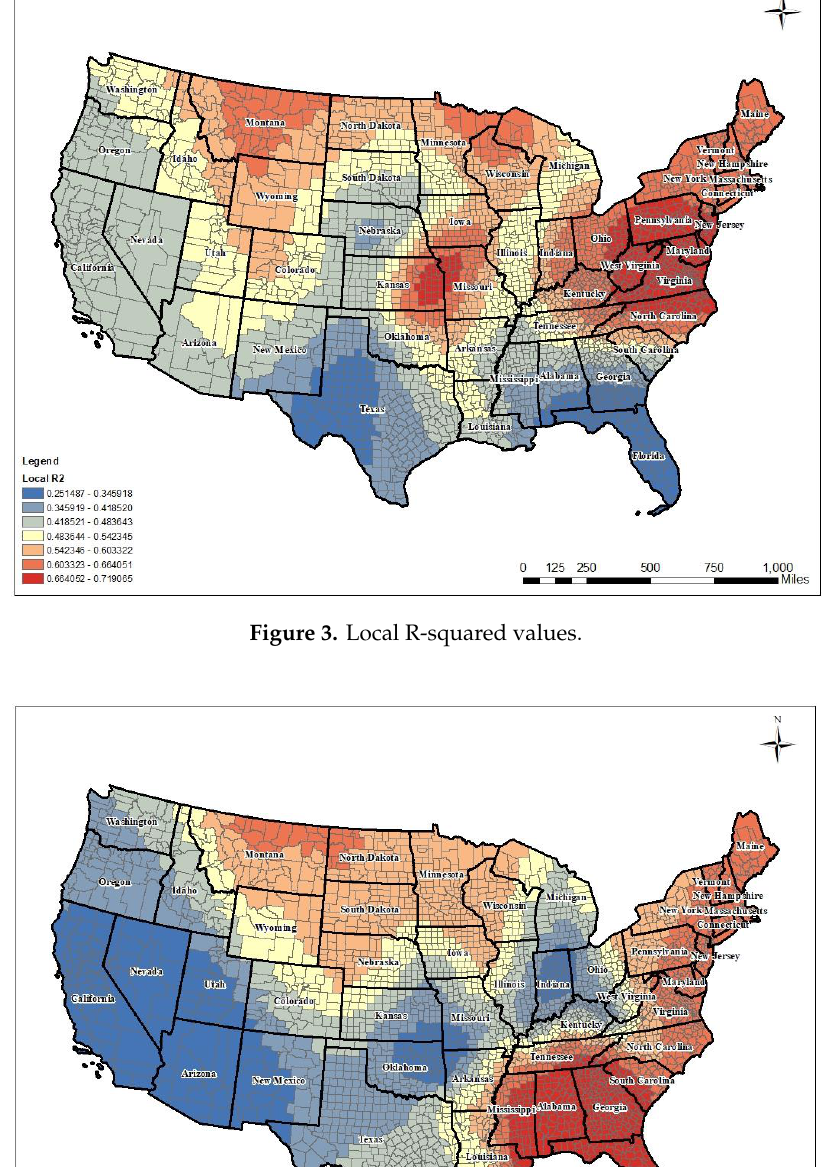
Figure 3. Local R-squared values.